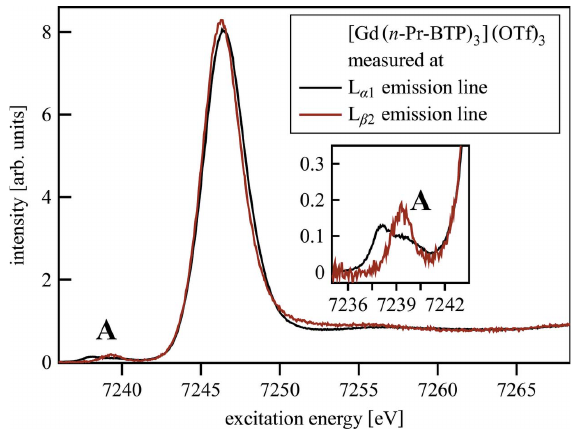
Figure 5 Calculations of [Eu( n -Pr-BTP) 3 ](OTf) 3 with FEFF and FDMNES with FMS and FP compared with the experimental